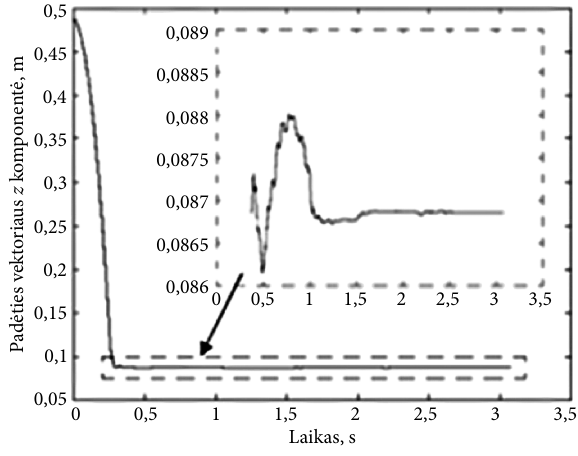
Fig. 11. Inactive zone of the particle mixture in the quasistatic equilibrium state